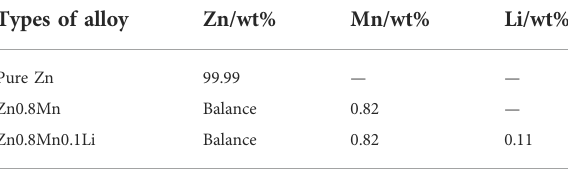
TABLE 1 Actual composition of Zn-based alloys. Types of